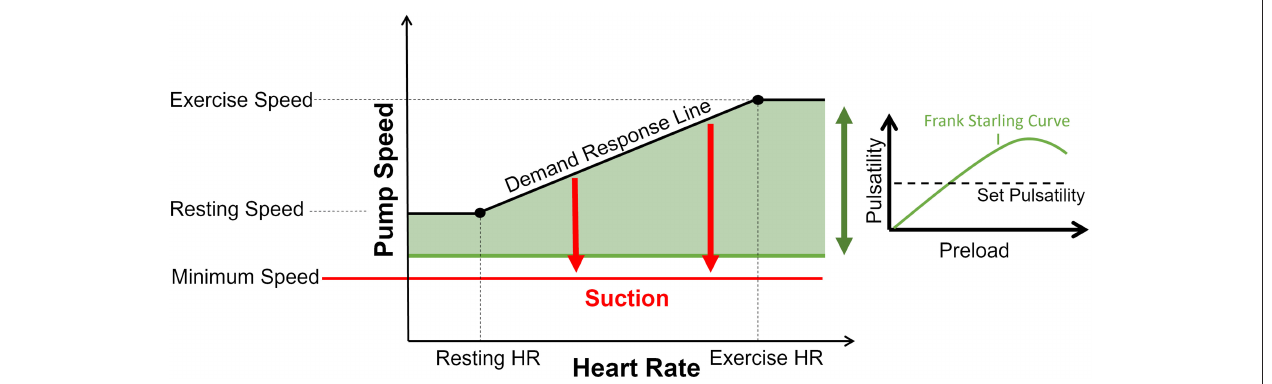
FIGURE 1 | Graphic representation of the control algorithm. The demand response submodule sets an upper speed limit based on heart rate. The flow pulsatility is partially governed by the Frank Starling curve of the ventricle (in the right panel). If flow pulsatility exceeds the set-point, sufficient filling is expected and speed is increased proportionally up to the demand response line (black). Conversely, if flow pulsatility is below set-value, speed is decreased, eventually down to the minimum speed limit. If suction is detected, speed is reduced by discrete steps until suction is cleared. If speed is decreased to minimum speed (red line) and suction is still present, speed is not further decreased. Speed is increased once suction is no longer present.